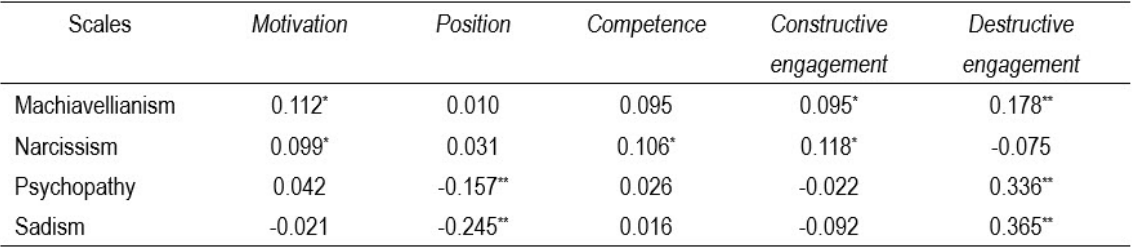
Spearman’s correlations